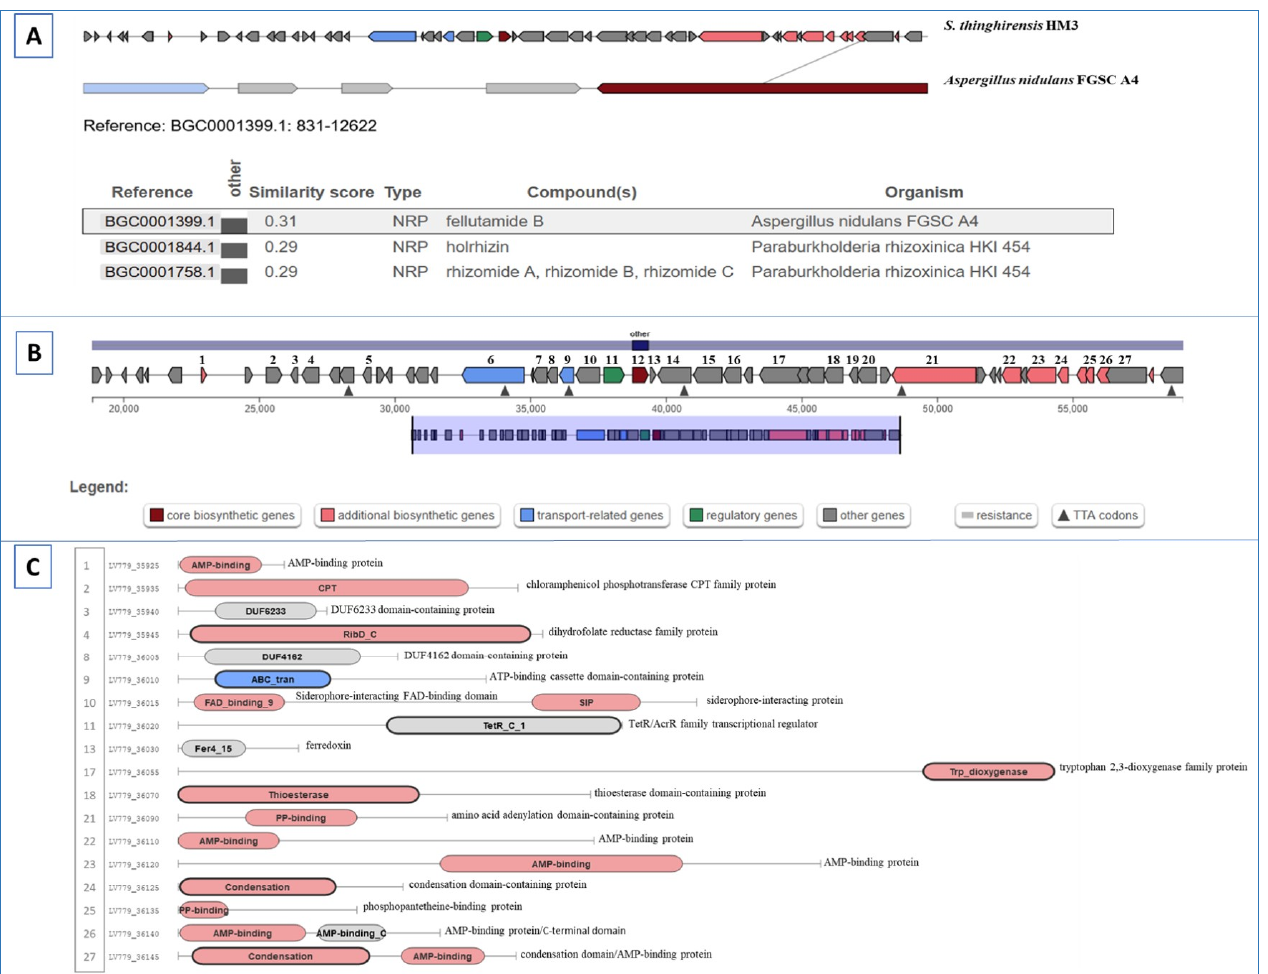
Figure 10. The proposed actinomycin D biosynthetic gene cluster in S. thinghirensis HM3. ( A ) The MIBiG comparison between the proposed BGC in strain HM3 and the proposed identified cluster of fellutamide B in Aspergillus nidulans FGSC A4, with a similarity score of 0.31. ( B ) The proposed actinomycin D-BGC in region 62.1 of the genome; 5, ANTAR domain-containing protein; 6, excinu- clease ABC subunit UvrA; 7, ABC transporter permease; 12, LmbU family transcriptional regulator; 14, cytochrome P450; 15, methyltransferase domain-containing protein; 16, aminotransferase; 19, phosphopantetheine-binding protein; 20, alpha/beta fold hydrolase. ( C ) represents the Pfam do- mains involved in actinomycin D biosynthesis.